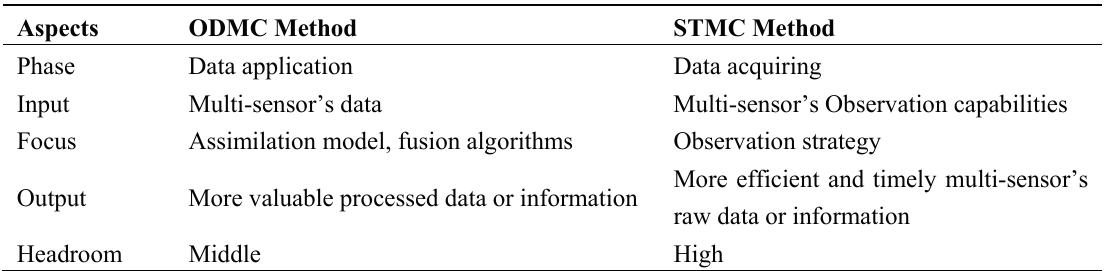
Table 3. Approaches comparison between the traditional ODMC method and the proposed STMC method from five aspects: phase, input, focus, output, and